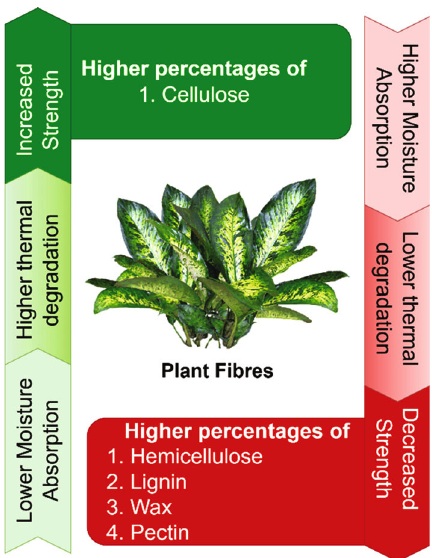
Figure 3: Chemical components of natural fi